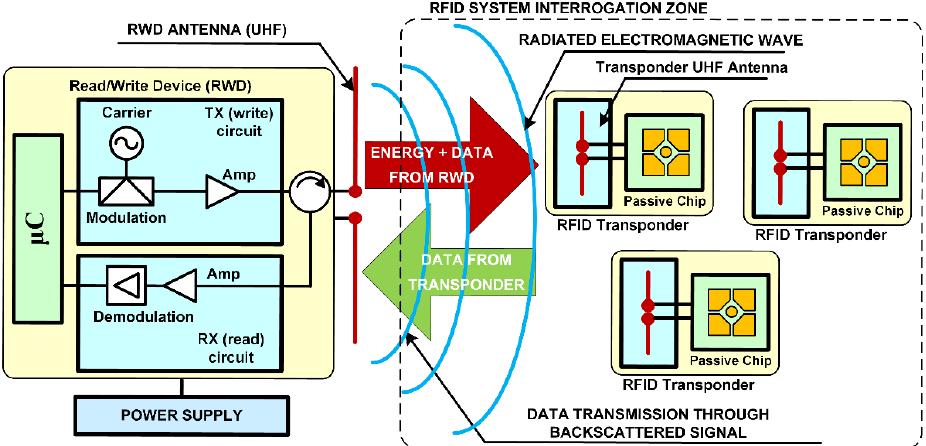
Figure 1. Simplified block diagram of the multiple RFID system.